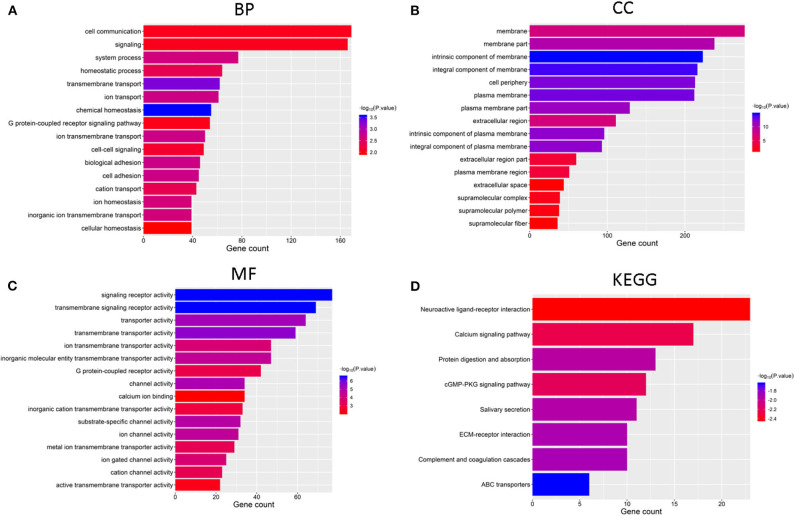
Functional annotation of differential expression of GBM in the two subgroups, Functional annotation of the genes with lower expression in the cluster2 subgroup using GO terms of biological processes (A), cellular component (B), molecular function (C), and KEGG pathway (D).